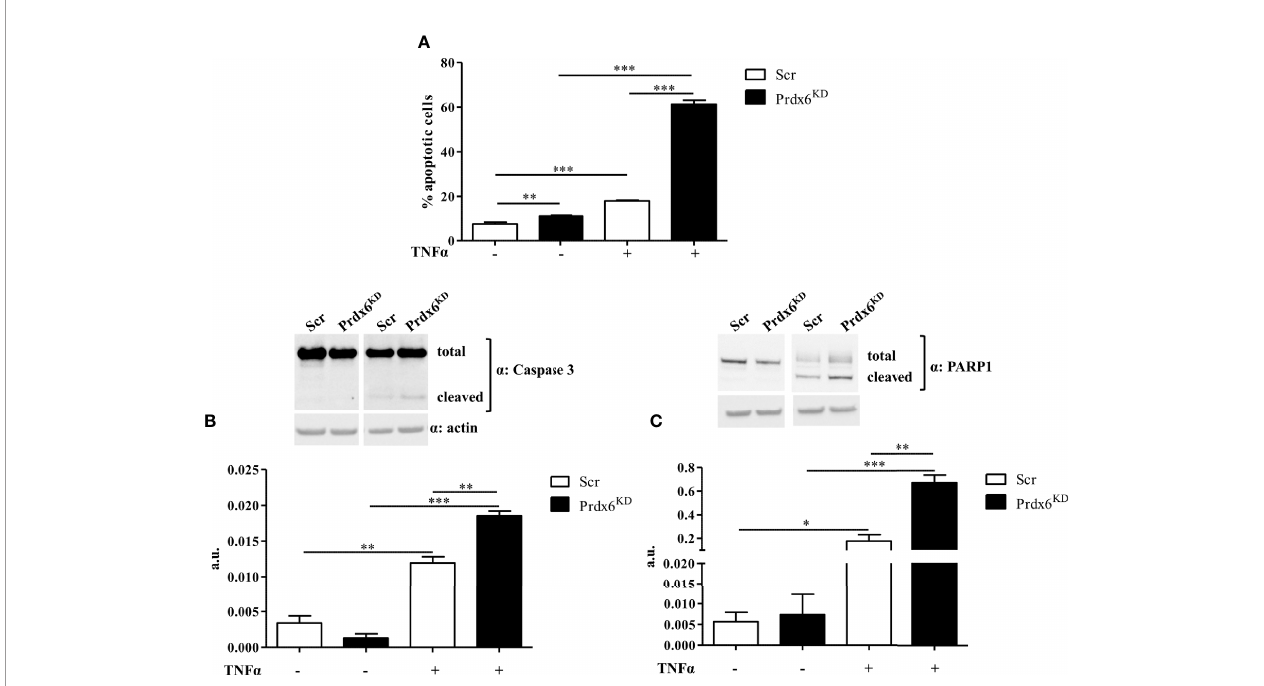
FIGURE 6 | Apoptotic death induced by TNF- a . (A) Apoptotic cell death was analyzed by fl ow cytometry following propidium iodide staining in both Prdx6 KD (black- fi lled bar) and Scr (white- fi lled bar). Fifty micrograms of Prdx6 KD (black- fi lled bar) and Scr (white- fi lled bar) total protein lysates was immunoblotted with speci fi c antibodies against caspase 3 (B) and PARP-1 (C) . All values were normalized with actin as a loading control. All values are expressed as mean ± SEM. *p < 0.05, **p < 0.01, ***p < 0.001 (n = 5). a.u., arbitrary